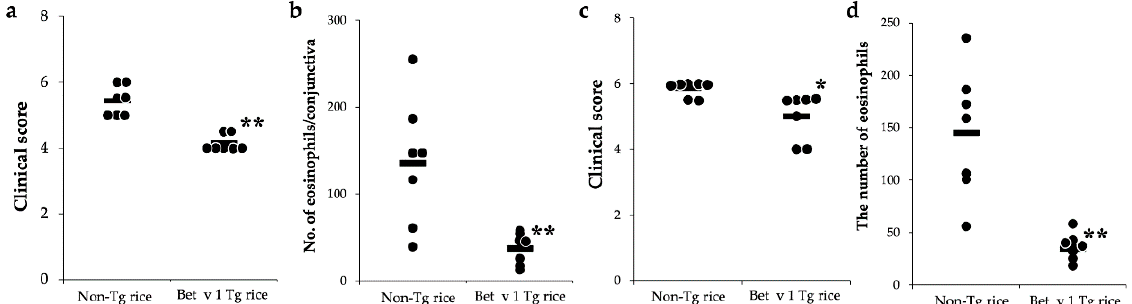
7 of 12 Figure 6. Serum concentration of total IgE ( a ) and Bet v 1-specific IgE ( b ) in mice fed with Tg or non- Tg rice. Data are presented as ng/mL or absorbance units. * p < 0.05, Tg vs. non-Tg rice-fed group according to unpaired Student’s t test (three mice per group). Figure 7. The release of IFN- γ ( a ) and IL-4 ( b ) by the antigen-stimulated splenocytes from mice fed with Tg or non-Tg rice. Data are means ± SEM. * p < 0.05, Tg vs. non-Tg rice-fed group according to unpaired Student’s t test (three mice per group). Table 2. Number of CD4+CD25+Foxp3+ Treg cells in mice fed Tg rice or non-Tg rice. Non-Tg Rice Tg Rice Mesenteric lymph node